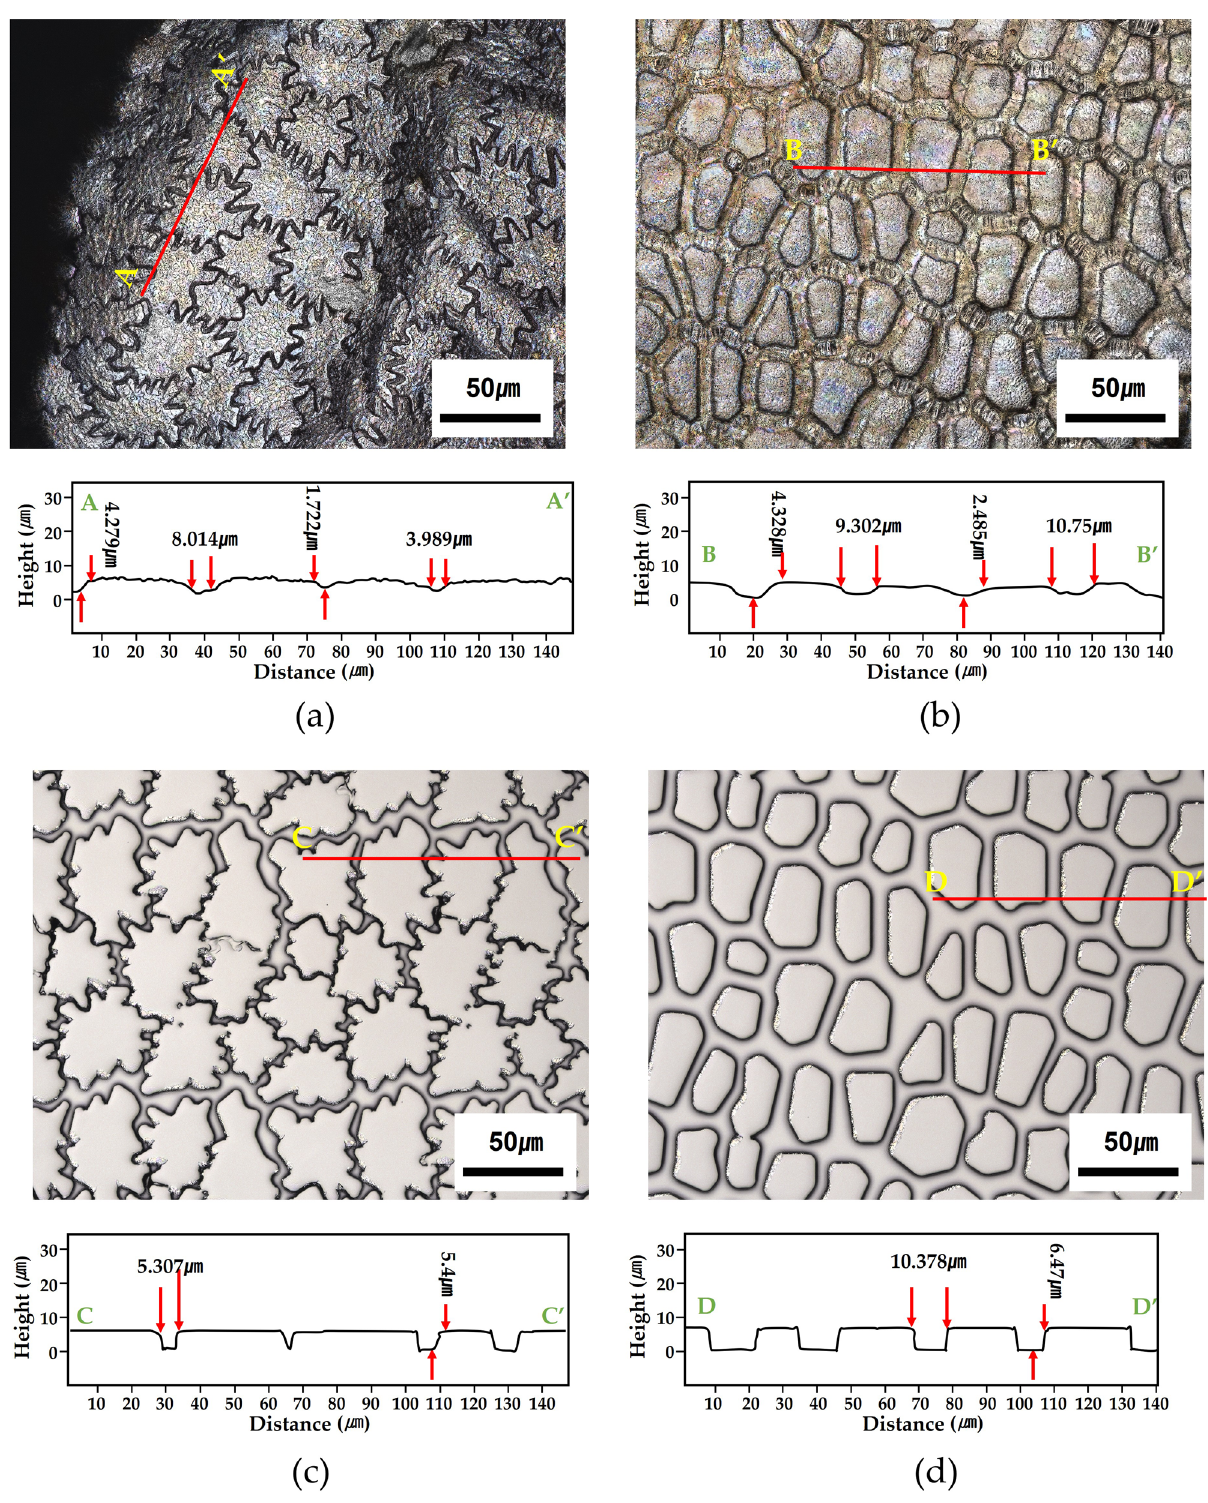
Figure 6. 3D surface profiles of biological and synthetic seed samples; Microscope image and cross-sectional profile of ( a ) Allium anisotepalum and ( b ) A. carolinianum seeds; microscope image and cross-sectional profile of the seed surface replicas of ( c ) A. anisotepalum and ( d ) A.